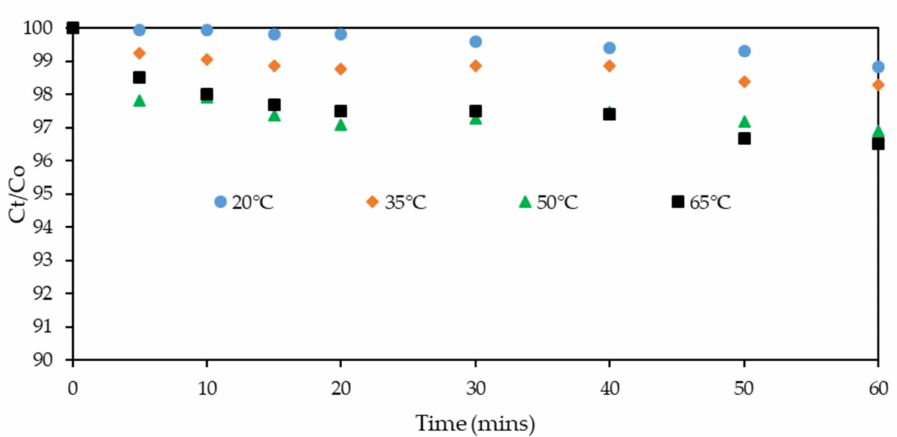
Figure 1. Average sodium isobutyl xanthate (SIBX) concentration with time at di ff erent temperature conditions. The diagram was rescaled to show di ff erences in concentration. Two way ANOVA analysis was employed for testing the statistical significance of di ff erences in concentration at a 95% confidence